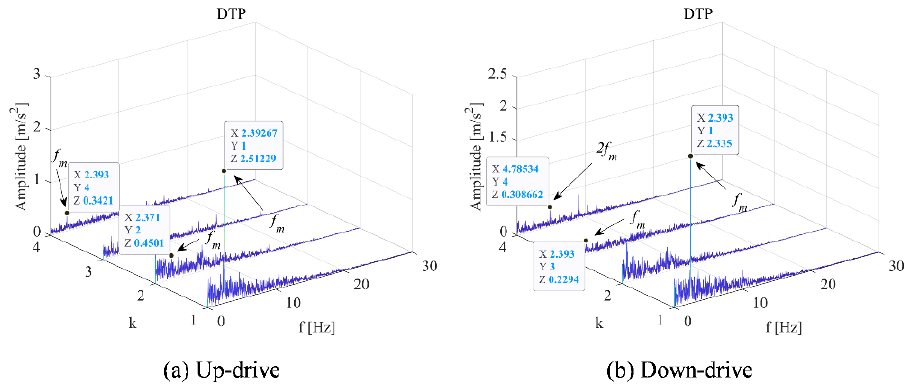
Figure 7. Vibration demodulation diagram under different operating conditions (2.4 m/s). ( a ) Motor with up-drive condition. ( b ) Motor with down-drive condition.